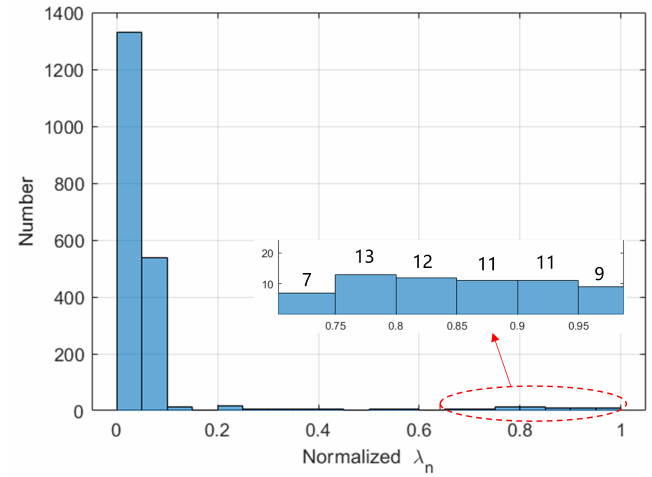
Figure 8. Histogram of eigenvalue distribution.